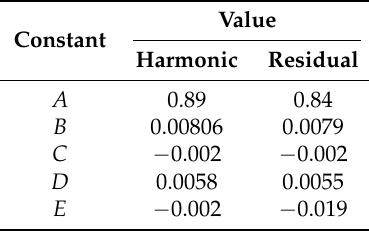
, F (cid:48) and F (cid:48) to modify formant locations. 2 3 1